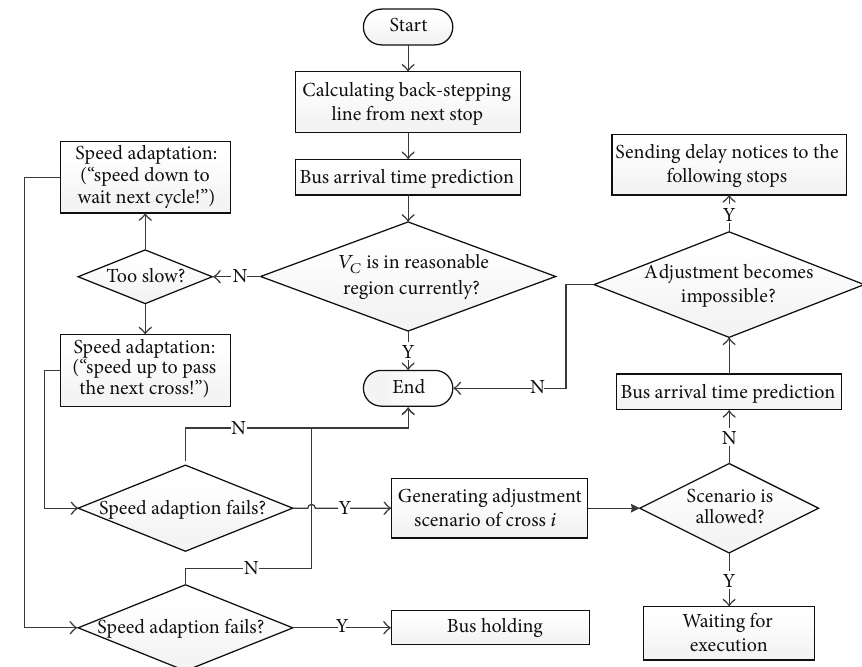
Figure 3: Flow chart of the control